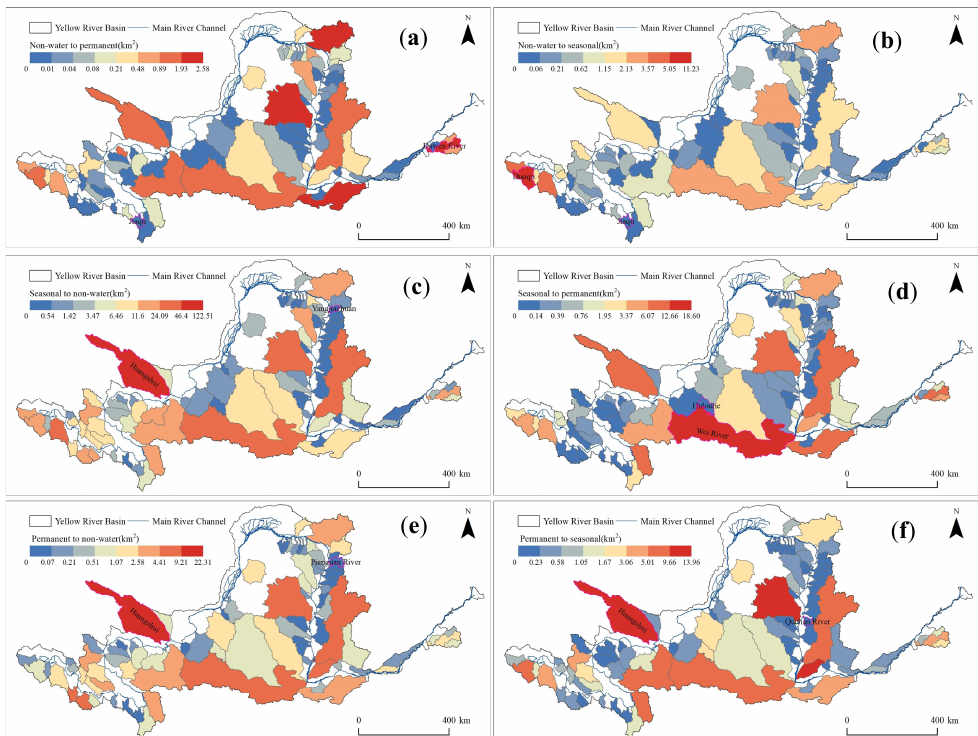
Figure 14. The different water body conversion types from 1986 to 2019 in the YRB. Panels ( a – f ) are for non-water to permanent, non-water to seasonal, seasonal to non-water, seasonal to permanent, permanent to non-water, and permanent to seasonal conversions, respectively.